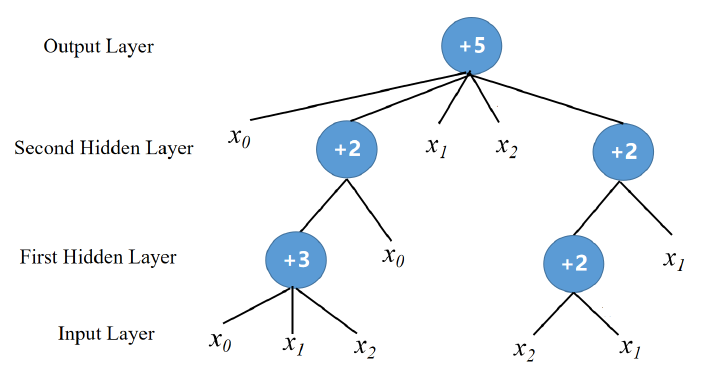
Figure 4. The algorithm flowchart of